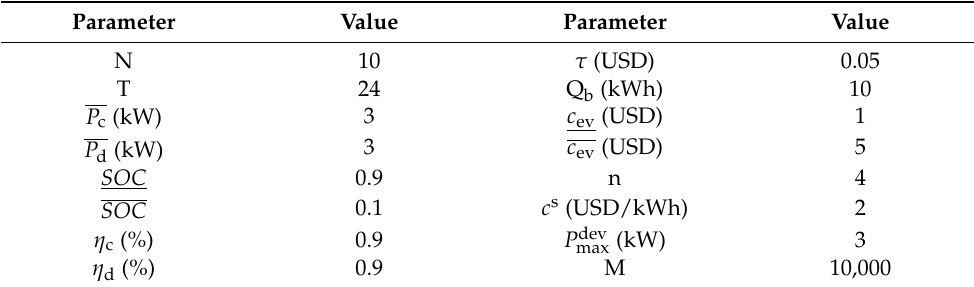
Figure 2. IEEE 33-bus distribution network diagram. Figure 2. IEEE 33 - bus distribution network diagram. Table 1. Parameters in the case